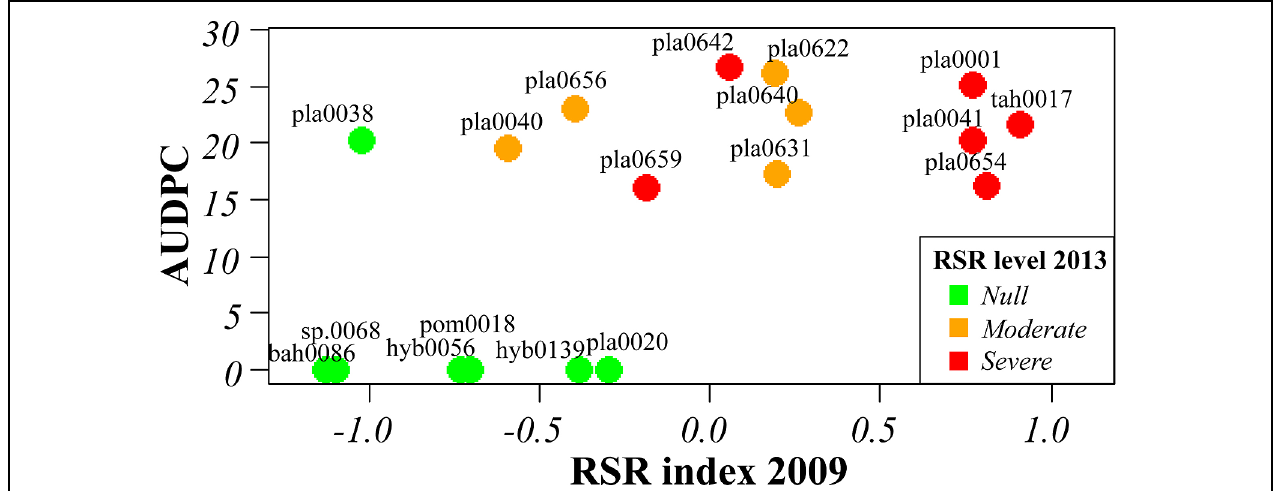
FIGURE 4 | Microscopic images of transverse root sections of pla0001 infected with Fo072 showing the colonization and penetration processes. (A) wide field microscopy (WFM) images showing the abundant mycelia network (pointed with arrows) on pla0001 double-stained with Schiff reagent and Naphthol Blue-black stained at 3 dpi and (B) showing the penetration of Fo072 hyphae through the passage cells (Pa) of the hypodermal layer (Hy) in pla0001(denoted with arrows) at 3 dpi. (C,D) Multiphoton microscopic images showing transverse sections of Fo072-infected pla0001 stained with DAPI showing the formation of hyphal coiled structures (denoted with arrows) in the rhizodermal cells (Rh) during the penetration process. (Co) = Cortical region. Scale bar: 20 μ m.